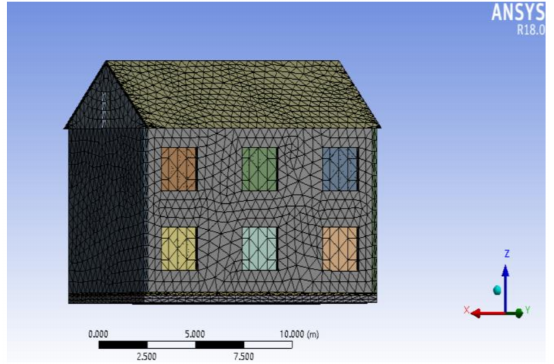
Figure 7. Refined mesh